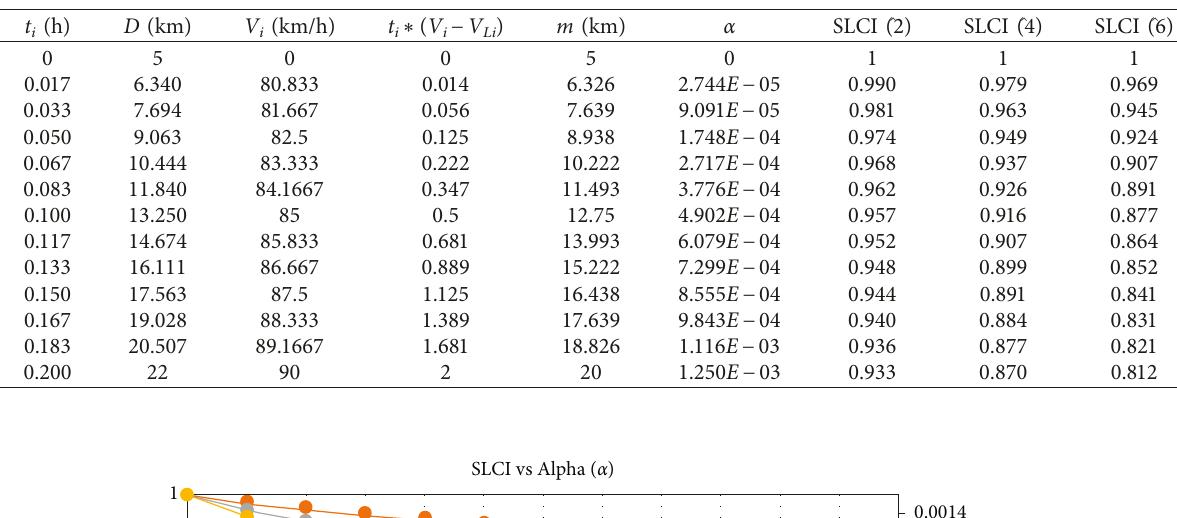
Figure 4: Schematic illustration of the parameters of the example. Table 2: The breakdown data of the example.